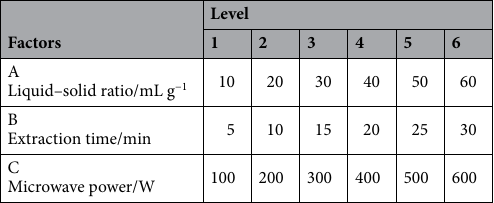
Table 2. Factors and levels in the single-factor